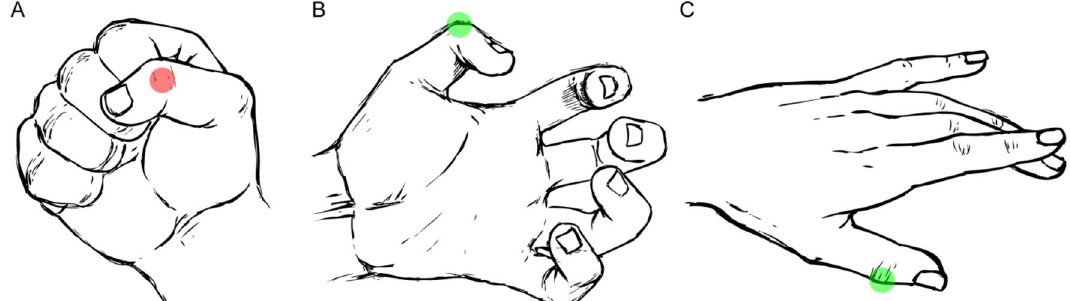
Figure 1. Correspondence problem and possible solutions. A major computational challenge is establishing correspondence between ( A ) and ( B )–( C ) across changes in viewpoint, object pose or non-rigid re-configuration. Observers generally have strong intuitions about the ‘correct’ solution, often with high agreement between observers. Drawings by Robert Marzullo (2017, https ://ramst udios comic